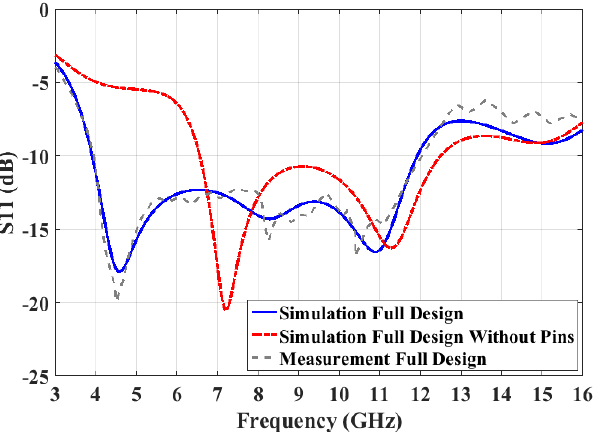
Measurement and simulation results of S-parameters of suggested full structure with V-shaped slot.